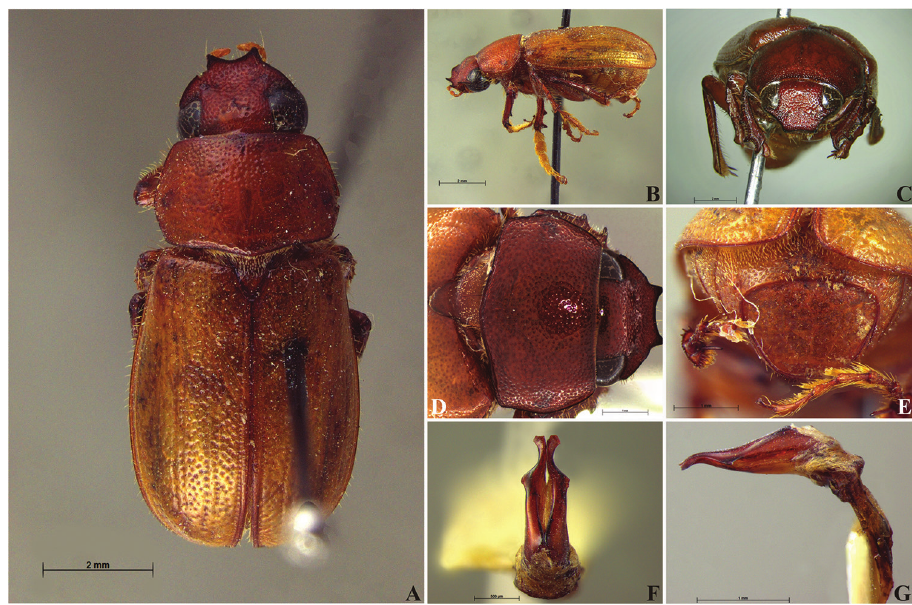
Figure 56. Liogenys acutidens Moser. A Dorsal view B Lateral view C Frontal view D Clypeus and pro- notum E Pygidium F Parameres, dorsal view G Parameres, lateral